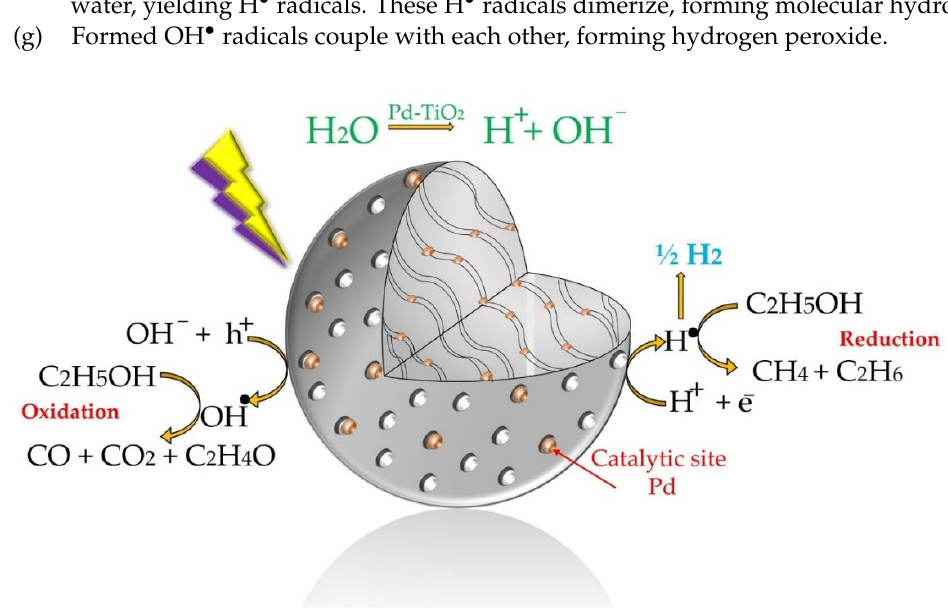
Figure 1. Schematic description of hydrogen formation reaction steps using Pd-TiO 2 as a photocatalyst and ethanol as a scavenger.